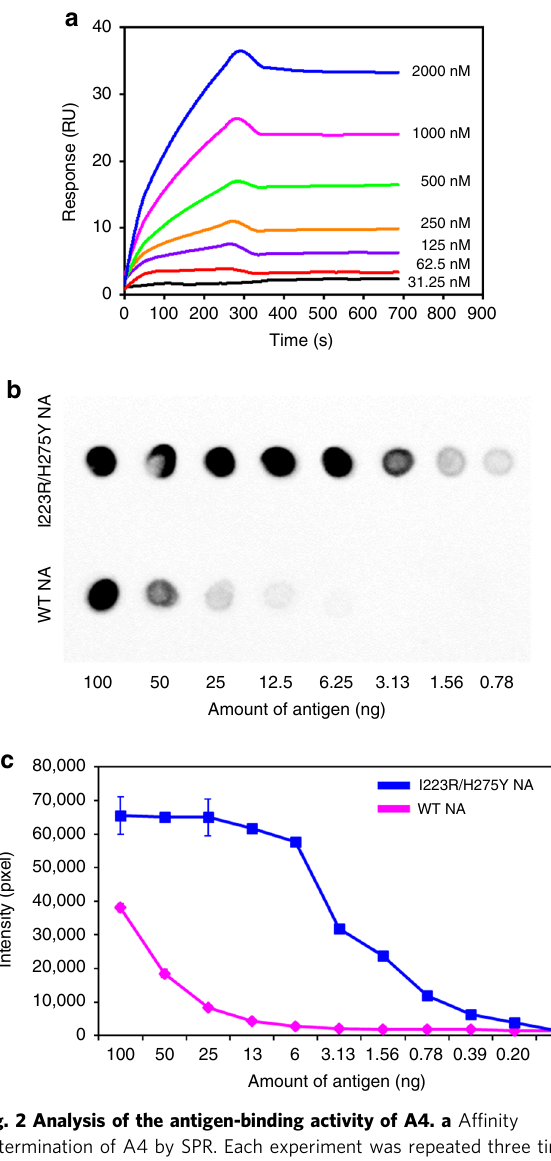
Fig. 2 Analysis of the antigen-binding activity of A4. a Af fi nity determination of A4 by SPR. Each experiment was repeated three times independently with similar results. b Speci fi c interaction between A4 and NA by dot-blot analysis. A4 was applied to wt NA and I223R/H275Y NA dotted in a twofold dilution series (0.78 – 100 ng mL − 1 ), and HRP-conju- gated anti-human IgG Fc was applied for detection. Each experiment was repeated three times independently with similar results. c The binding activity of A4 by densitometric analysis. All ELISA values were obtained from triplicate wells and are expressed as the mean. Error bars = standard deviation ( n =